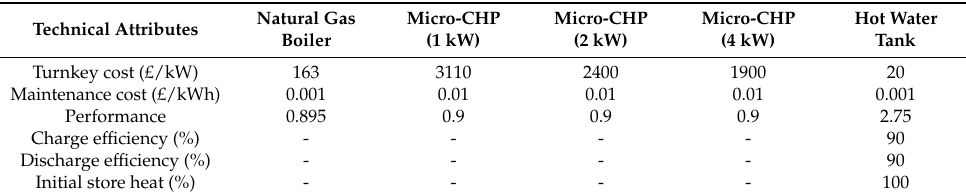
Table A1. Technical attributes of technologies in superset